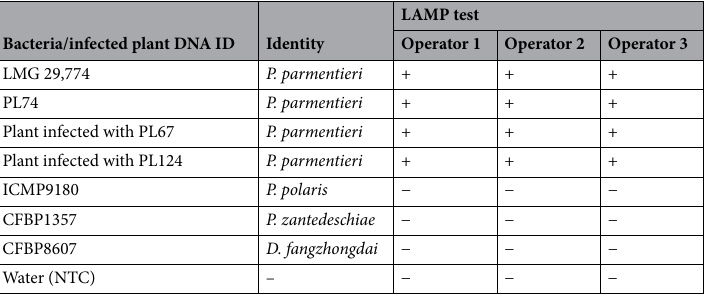
Table 5. Multi-operator validation of loop-mediated isothermal (LAMP) assay specific for Pectobacterium parmentieri